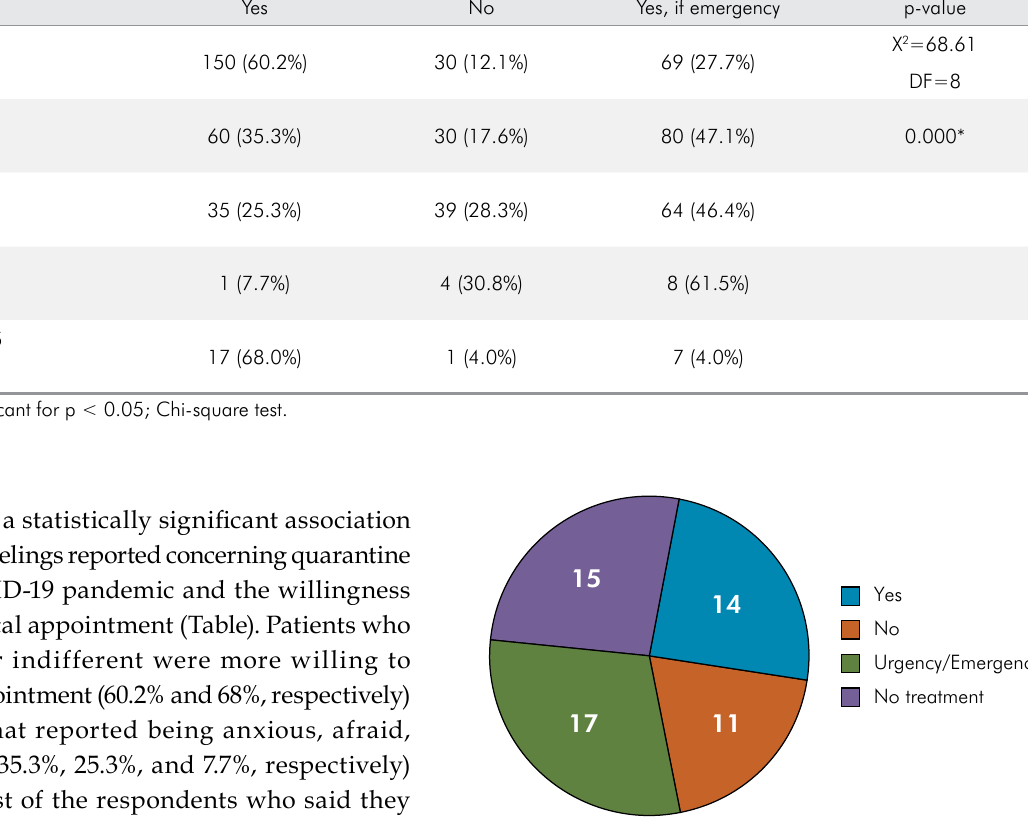
Table 1. Association of the feeling about the quarantine and the coronavirus pandemic and the willingness to go to a dental appointment.